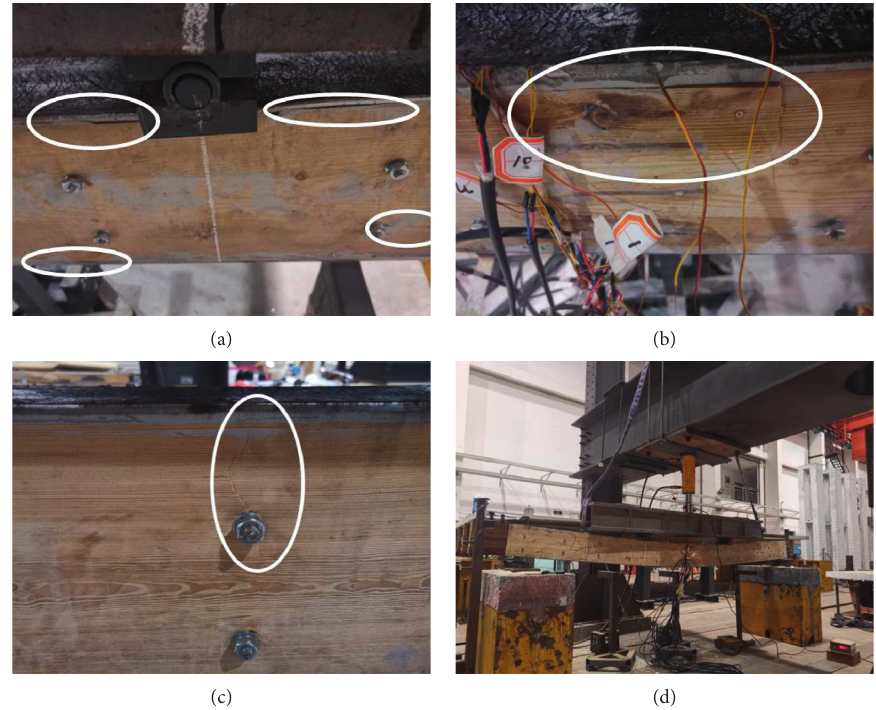
Figure 9: Failure mode of L4 test piece. (a) The right support begins degumming. (b) The upper flange is degummed and cracked. (c) Oblique crack at the edge of the bolt hole. (d) Bending damage.